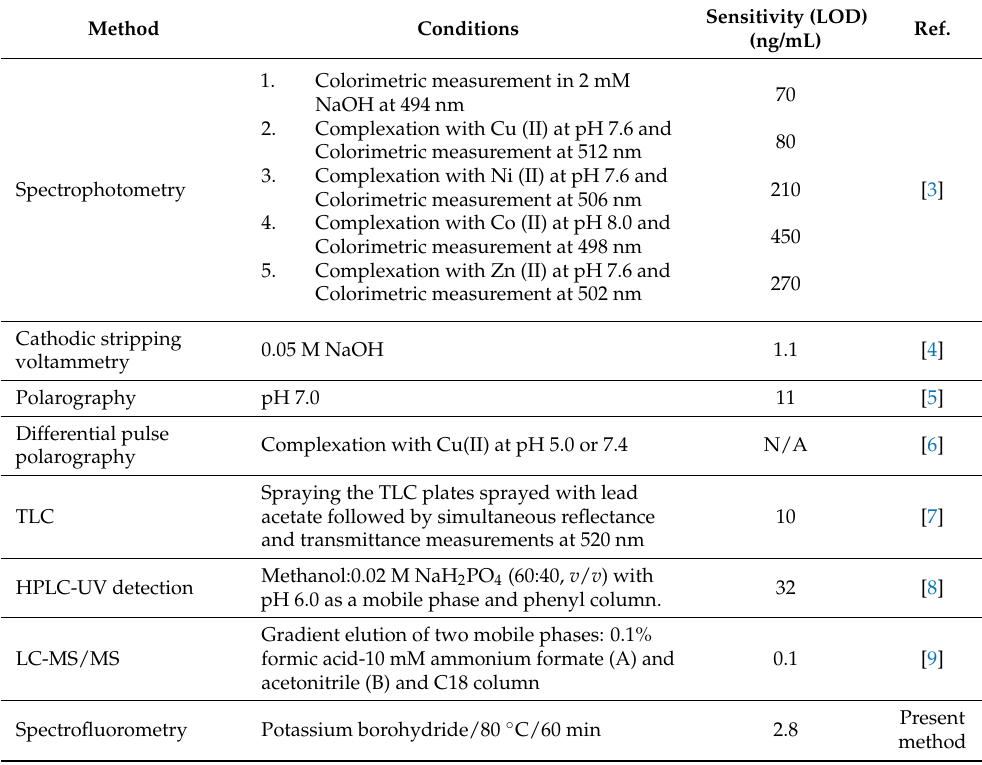
Table 8. Comparison of the proposed method’s performance with that of the literature